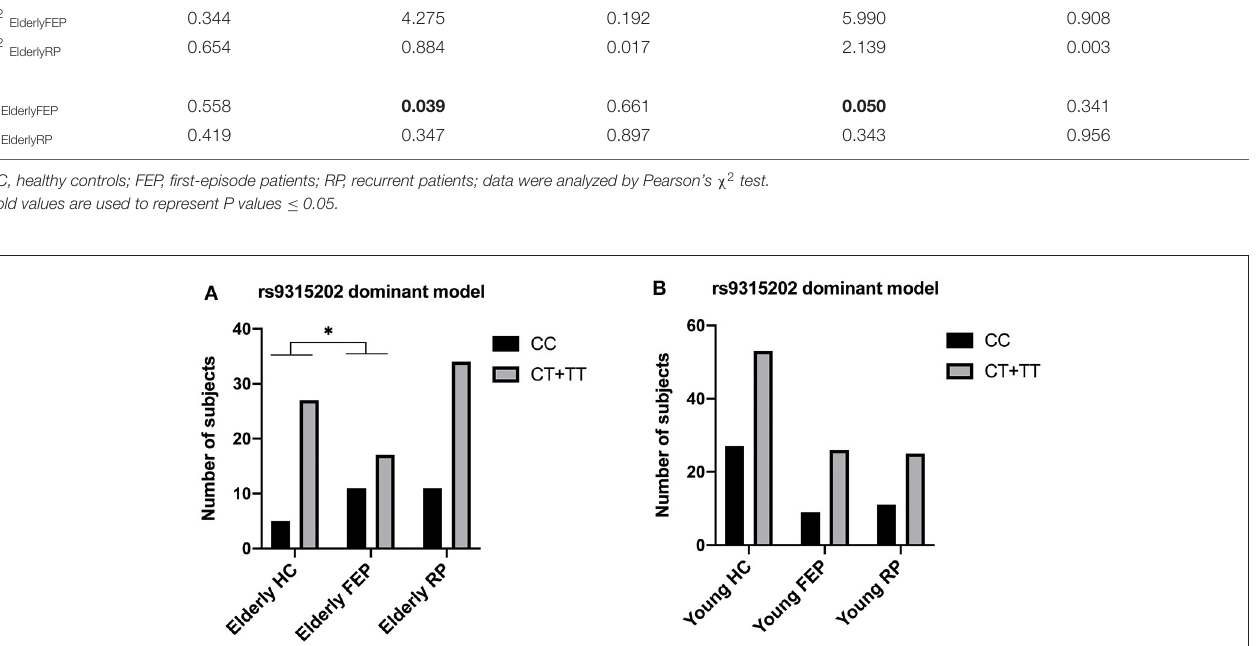
Frontiers in Psychiatry |